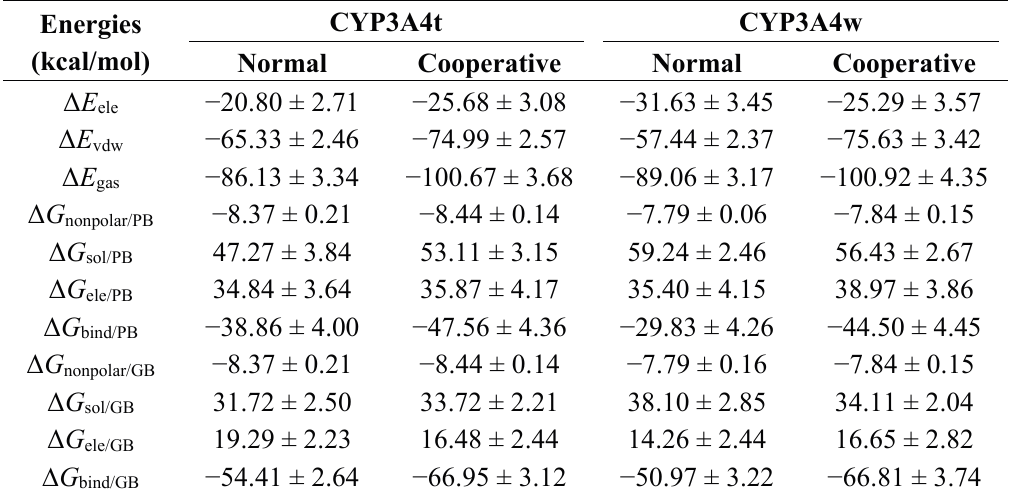
MM-PB/SA and MM-GB/SA methods for the normal and cooperative binding models of human